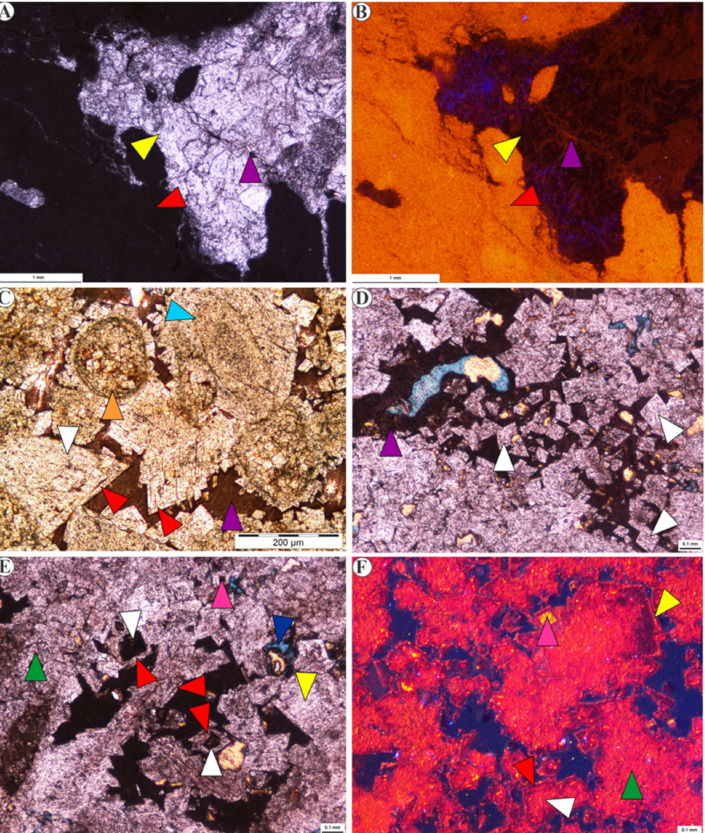
Figure 5. Photomicrographs of plane polarized and cathodoluminescence petrography showing: ( A , B ) yellow arrows pointing towards the cavity filling saddle dolomite (SD-I) in the finely crystalline replacive dolomite (RD-III) (ferroan dolomites) cross-cut by fracture filling calcite cement (CC-IV) (purple arrows). ( C ) Plane polarized photomicrograph of the fabric retentive replacive dolomites, completely replacing ooids (orange arrow) and peloid (blue arrow) wrapped by dolomite cement (DC-I and DC-II) (white and red arrows, respectively), the vacant pores spaces have been filled with calcite cement (CC-I) (purple arrow). ( D ) Crystallization of dolomite cement (DC-I) (white arrows) in the pore’s spaces. Most of the vacant spaces has filled by calcite cementation (CC-I) (purple arrow), while some are still vacant (light blue color elongated patch). ( E , F ) showing rhombohedral dolomite cement (DC-II) (red arrows) with cloudy cores DC-I (white arrows) filling the open spaces generated during the early phase dissolution and replacive dolomitization, red arrow indicates overgrowth rim of dolomite cement (DC-II) over the already formed dolomite cement DC-I, pink arrows point out the second phase of calcite cement (CC-II), i.e., calcitization/dedolomitization initiated at the core of the already formed rhombohedral dolomite cement, (yellow arrow) exhibit saddle dolomite (SD-I) crystallized in the pore’s spaces and blue arrow indicate the intercrystalline pores spaces. White arrows indicate the cloudy cores of the well-developed dolomite rhombs